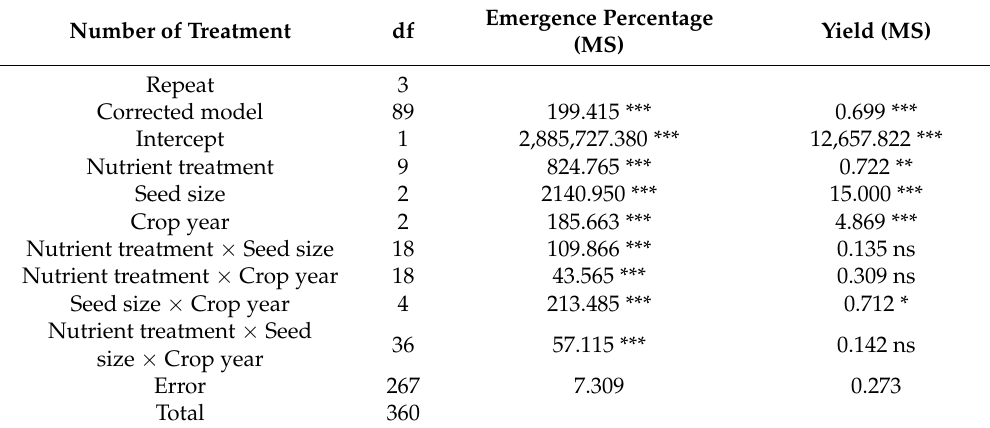
Table 3. Results of variance analysis of field investigations (MS: mean square values).